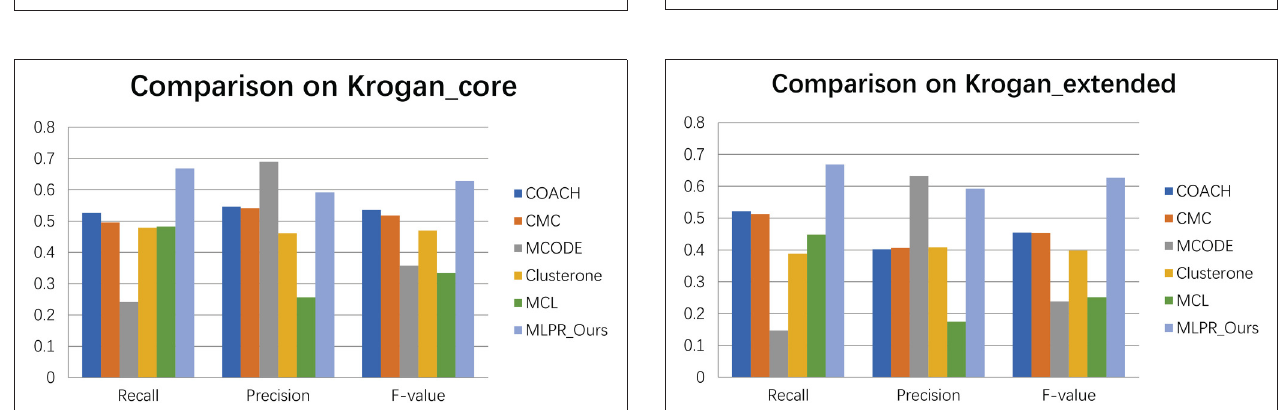
FIGURE 7 | The performances comparison between our method and other five methods on Gavin dataset.